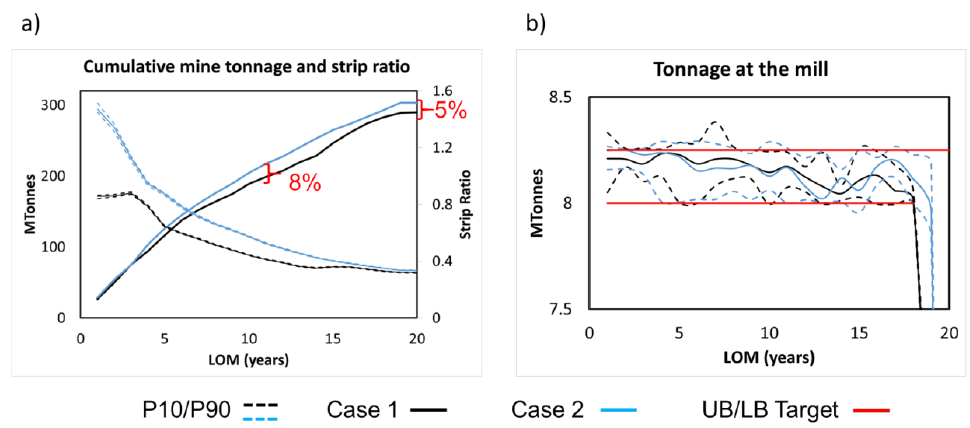
Figure 8. Horizontal sections of the mine production schedule at different elevations for ( a ) Case 1 and ( b ) Case 2. The red circles highlight the differences in pit sizes.